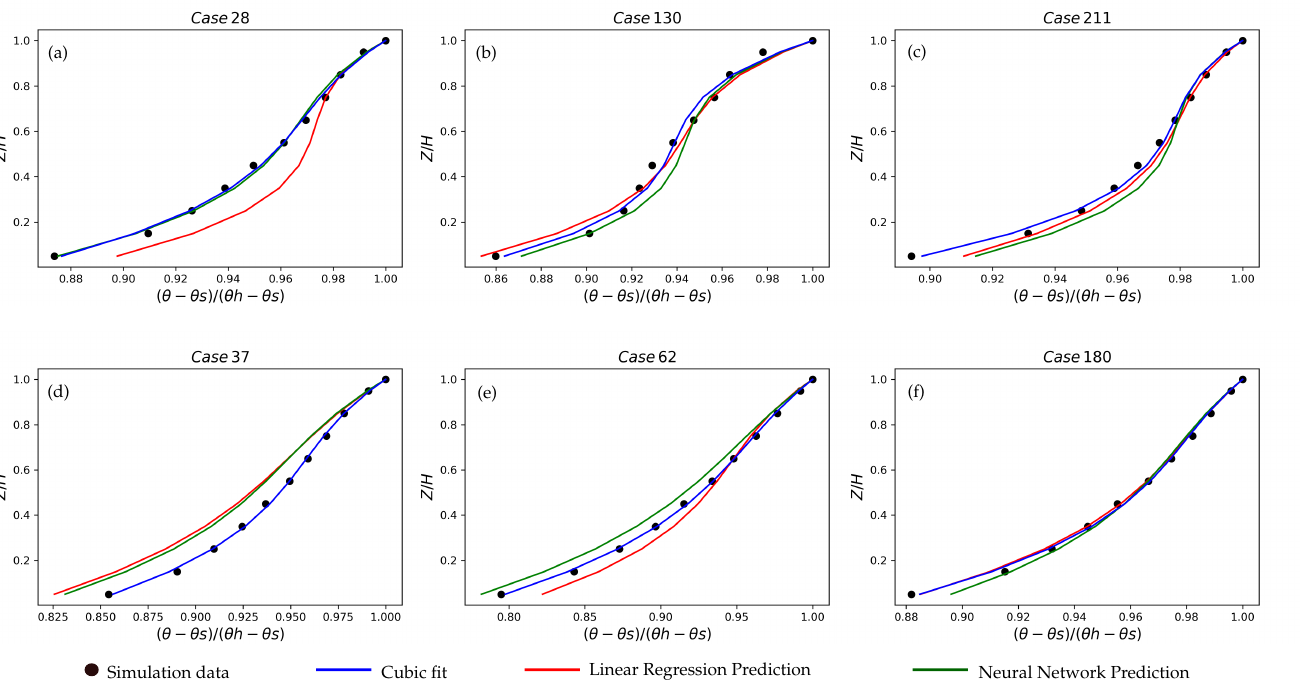
Figure 14. Cubic polynomial temperature prediction: linear regression vs. ANN for unstable cases ( a – c ) and stable cases ( d – f